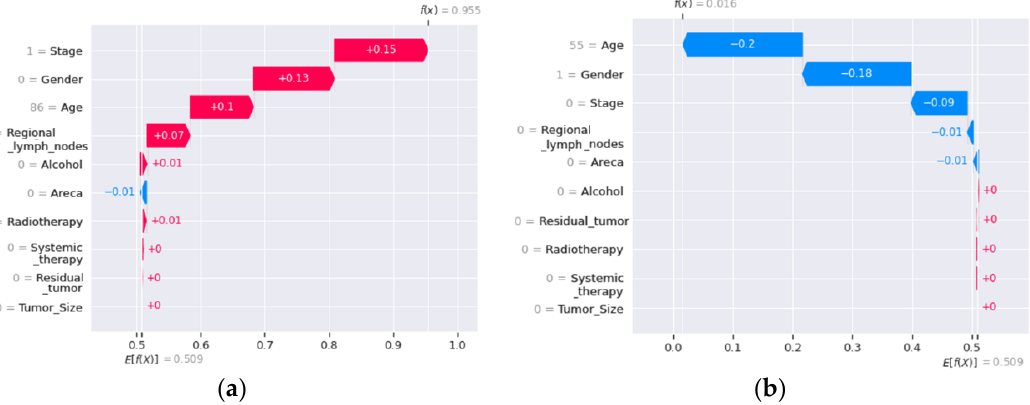
Figure 12. Waterfall plot. Two example instances for local interpretation: ( a ) SPSC case and ( b ) non-SPSC case. f(x) is the prediction probability and E[f(x)] is the expectation of probability (i.e., the average predictions of all the instances).